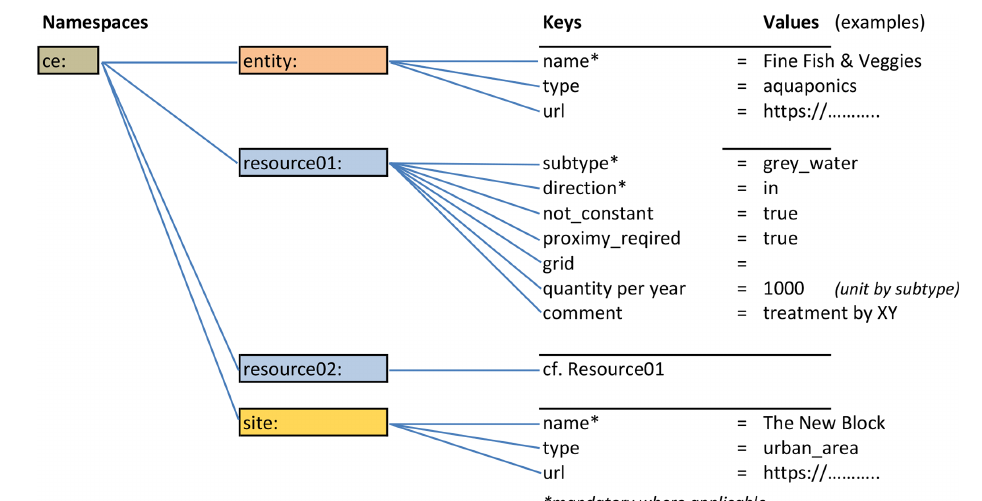
Figure 3. Proposed names for OSM tags within the namespace